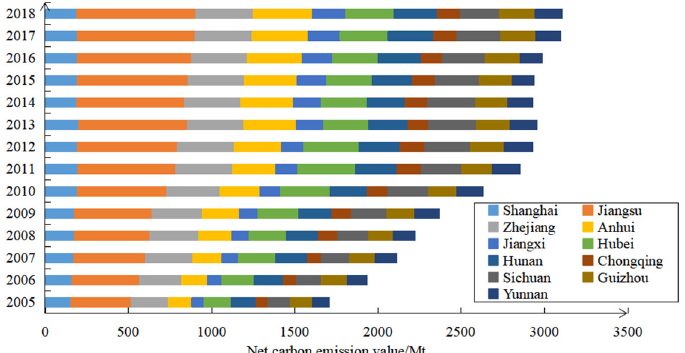
Figure 1. Net carbon emissions of 11 provinces and cities in the YREB from 2005 to 2018 [source: own illustration].